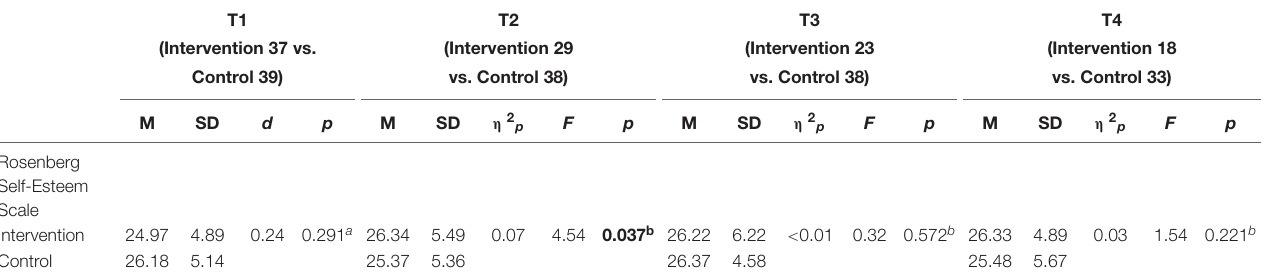
TABLE 3 | Differences in self-esteem between groups as measured by the Rosenberg Self-esteem Scale. T1 T2 T3 T4 (Intervention 37 vs.